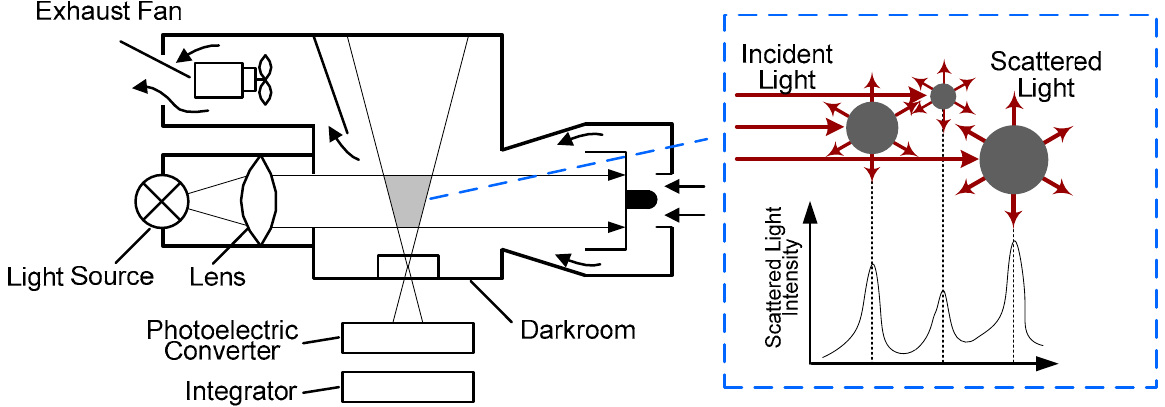
Figure 3. The working principle of light scattering particle sensor.